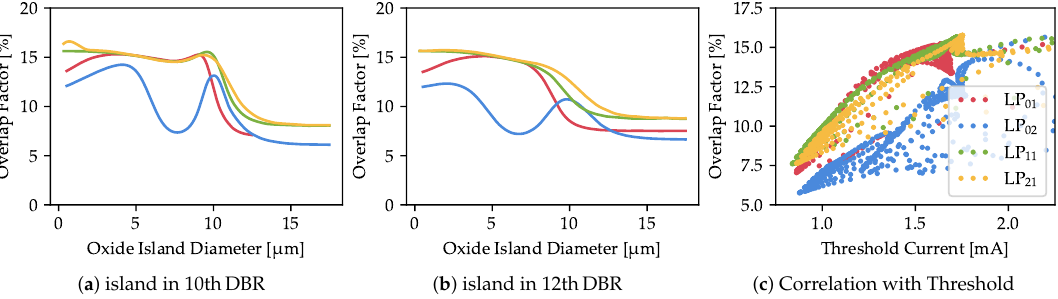
Figure 7. Overlap factor at threshold for the oxide island located in the ( a ) 10th and ( b ) 12th DBR pairs and ( c ) the correlation between the overlap factor and the threshold current for all island distances presented in Figure 6. The oscillations of the threshold current are not correlated with the overlap